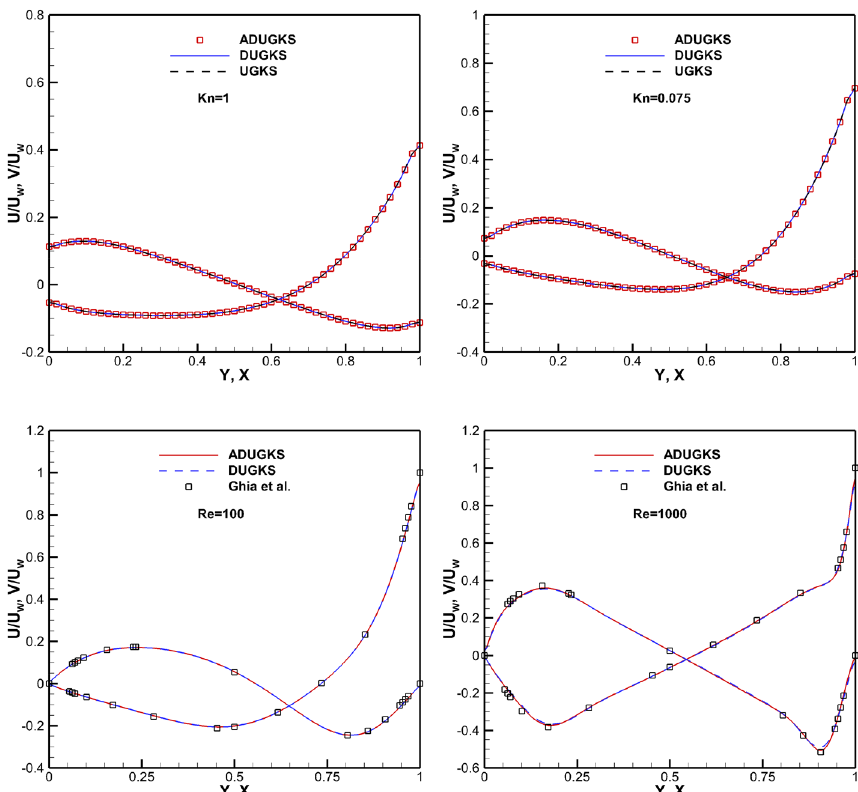
Fig. 4 Comparison of velocity profiles along the vertical and horizontal central lines of the cavity at different Knudsen/Reynolds